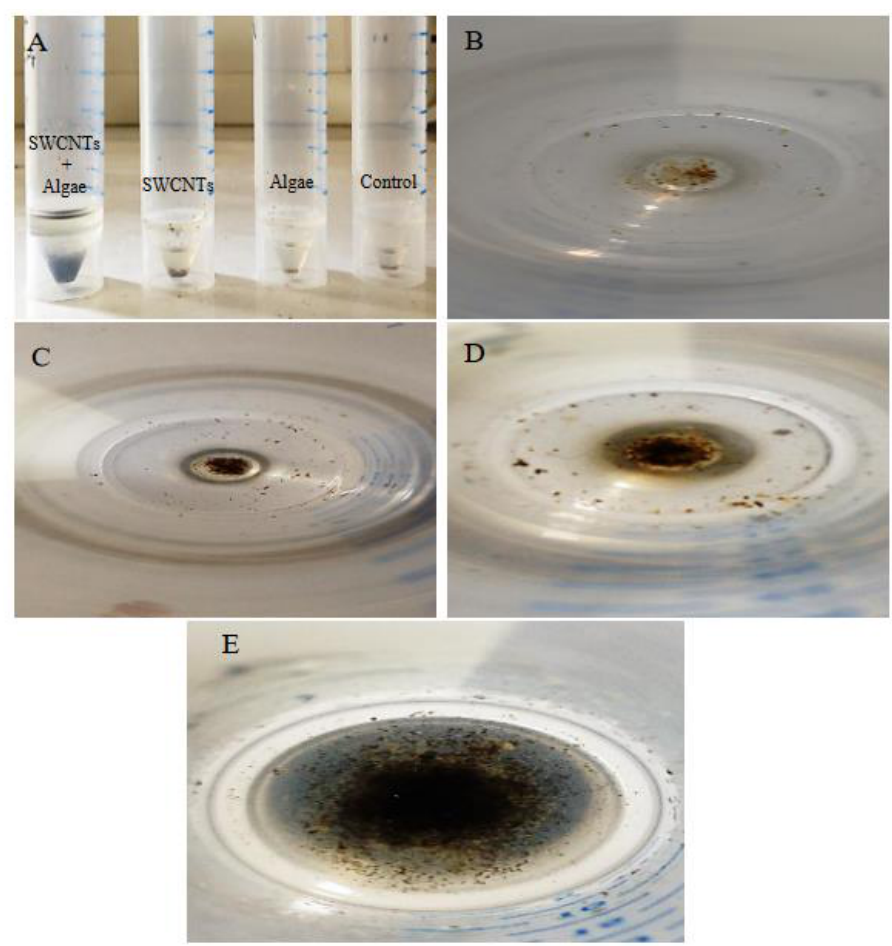
Figure 10. Feeding behavior of the mussel Mytilus edulis . ( A ) Faecal and pseudofaecal material expelled by the exhalant /inhalant siphons of the mussels when fed the algae, SWCNTs 500 µ g L − 1 alone and SWCNTs 500 µ g L − 1 + algae (lateral view of tubes). ( B , C ) Faecal material expelled by the exhalant siphon of the mussel when fed the Tetraselmis suecica alone. ( D ) Pseudofaecal material expelled by the inhalant siphon of the mussels when fed the SWCNTs 500 µ g L − 1 alone and ( E ) in combination with algae (( B – E ): vertical view).